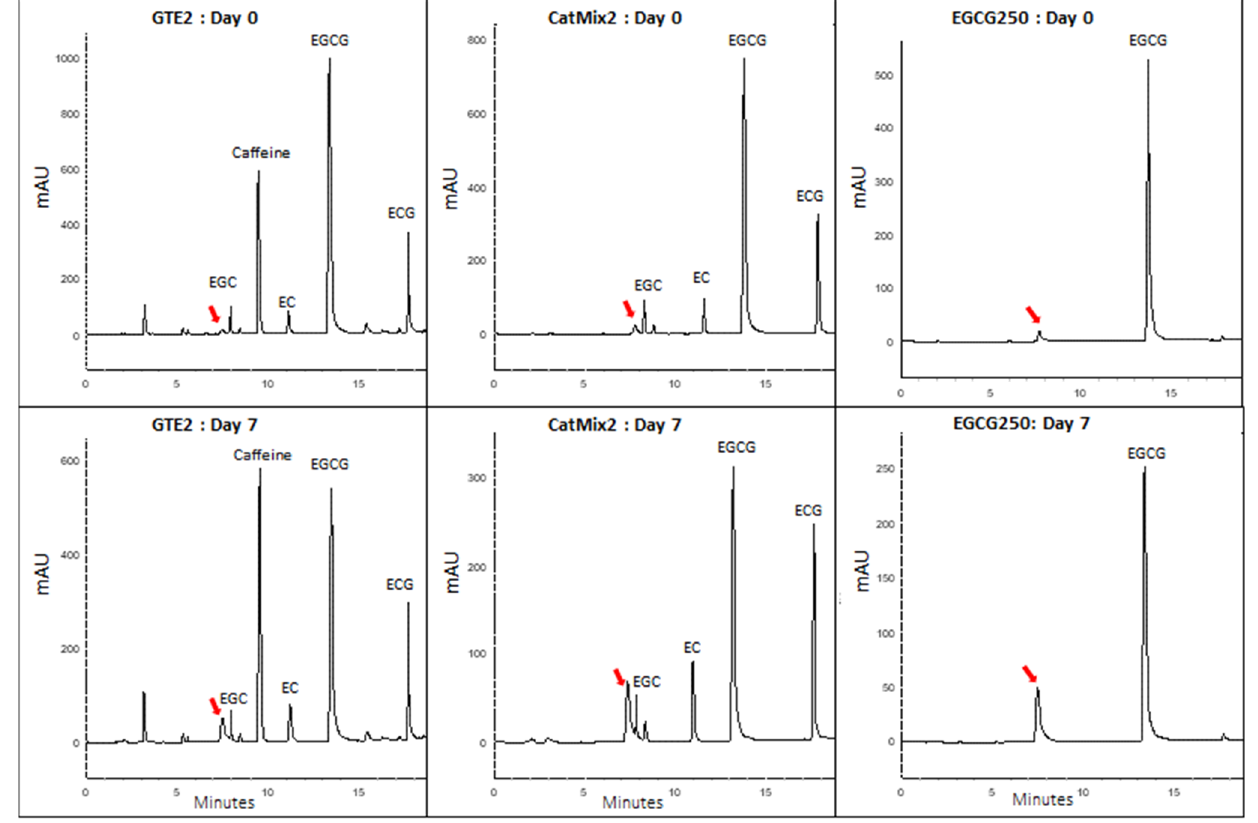
Figure 6. HPLC-UV chromatograms of a degradation product formed in catechins-supplemented DHA-rich oils during an accelerated storage test at 30 °C. GTE2 = DHA-rich oil + 450 ppm GTE2, CatMix2 = DHA-rich oil + reconstituted catechins mixture of GTE2, EGCG250 = DHA-rich oil + 250 ppm EGCG. The extracts from EGCG250-supplemented oil injected on HPLC were two times more diluted than the GTE2 and CatMix2 samples to avoid peak saturation. The degradation product is indicated by the arrow. Table 3. Changes in the content of an EGCG degradation product during the storage of a DHA-rich oil supplemented with a green tea extract rich in EGCG (GTE2), a corresponding catechins mixture (CatMix2) or pure EGCG (EGCG250) at 30 ◦ C for 21 days. Storage Time (Days)